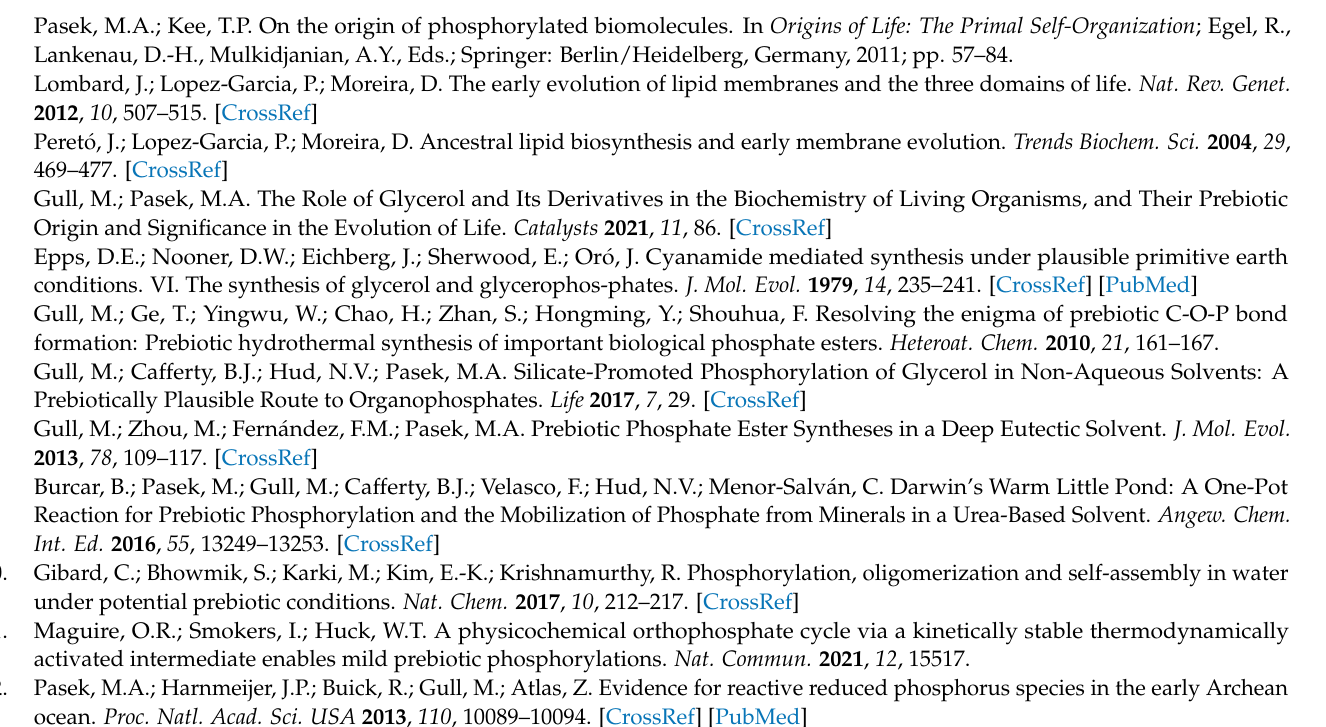
Figure S2: 31 P-NMR of GP formation in the presence of obsidian, Figure S3: 31 P-NMR of the standard glycerol phosphate, Figure S4a–h: 31 P-NMR of the decomposition reactions of the